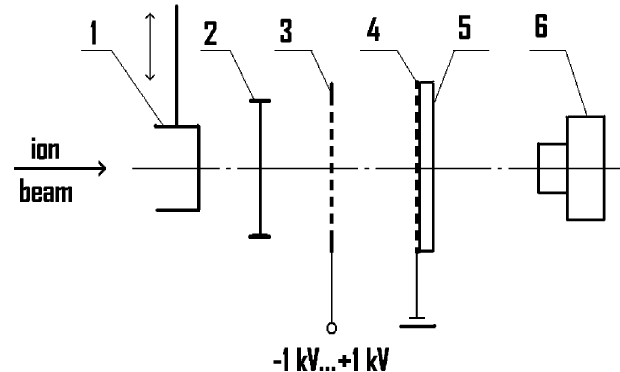
FIG. 3. Simplified scheme of the PPSS emittance probe: 1, movable FC; 2, fast iris-type shutter; 3, pepper-pot plate; 4, mesh; 5, CsI (Tl) crystal; 6, CCD